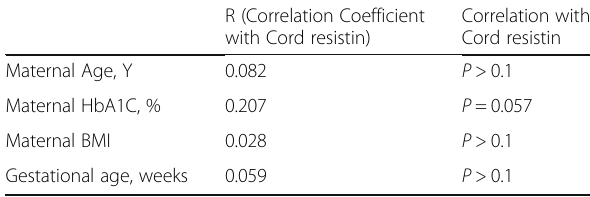
Table 2 Spearman tests on correlation of maternal factors with cord blood resistin levels R (Correlation Coefficient with Cord resistin)